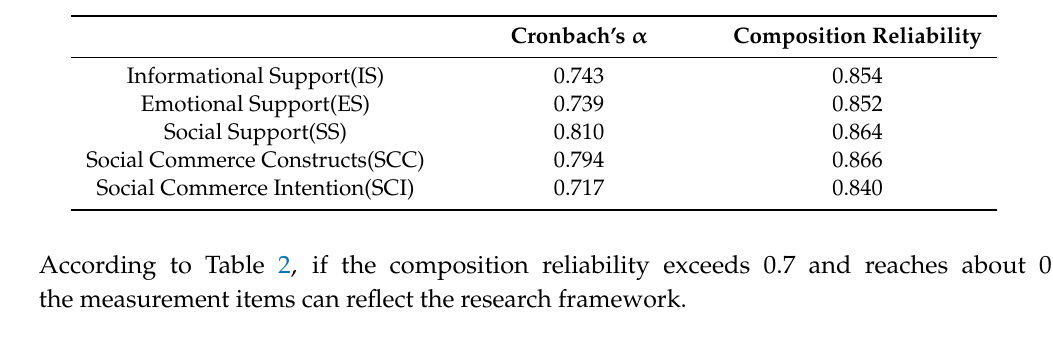
Table 2. Cronbach’s α values and composition reliability.